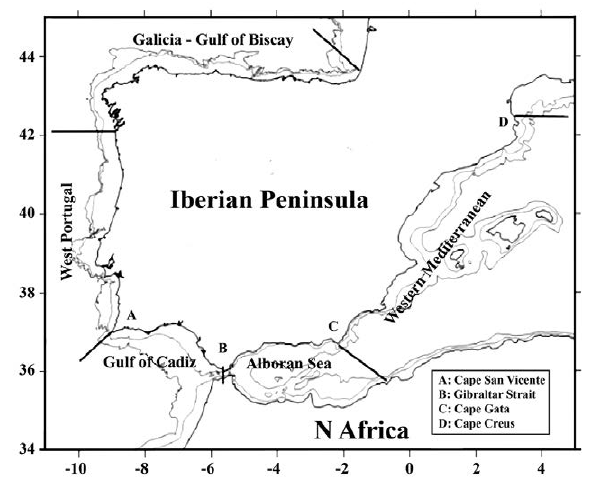
Fig. 1. – Map of the Iberian Peninsula and nearby waters show- ing the areas considered to characterize the spatial distribution of decapod crustacean species. The –200 and –1000 metres isobaths are shown. Areas: Gulf of Biscay and Galicia (GB-GA); western Portugal (WP); Gulf of Cádiz or southwestern Iberian Peninsula (GC); Alborán Sea (ALB); Spanish western Mediterranean (SWM). Explanation of letters in left lower corner of figure. Figure modified from Scientia Marina in Marco-Herrero et al.